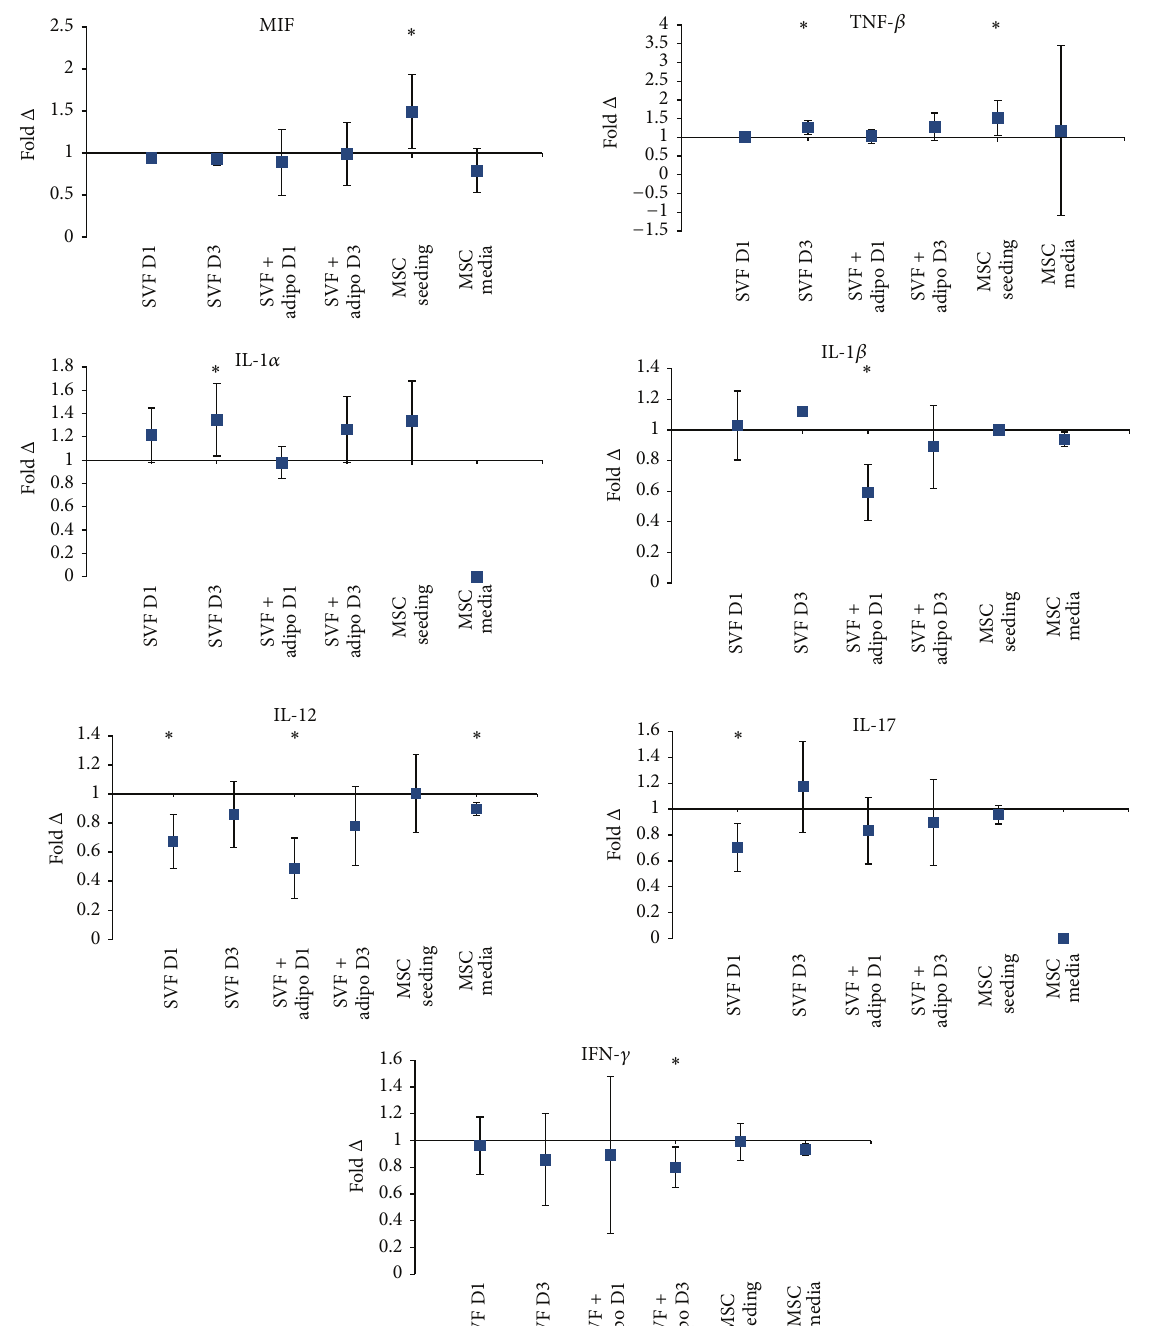
Figure 4: Fold change in concentration of proinflammatory cytokines detected across experiments Average fold change in concentration ( 𝑛 = 3 ) ± upper and lower confidence intervals at 95% ( 𝑦 -axis). Conditions ( 𝑥 -axis): stromal vascular fraction on day 1 (SVF D1), stromal vascularfractiononday3(SVFD3),stromalvascularfractionplusmatureadipocytesonday1(SVF+adipoD1),stromalvascularfractionplus mature adipocytes on day 3 (SVF + adipo D3), seeding experiment with purified MSCs (MSC seeding), and media change experiment with purified MSCs (MSC media). Conditions were all cultured in either standard culture media or HA media. Cytokines with a fold change less than one indicate a decrease in concentration with HA media treatment; a fold change greater than one indicates an increase in the cytokine with HA treatment. Macrophage migration inhibitory factor (MIF), tumor necrosis factor-beta (TNF- 𝛽 ; lymphotoxin-alpha), interleukin- 1 𝛼 (IL-1 𝛼 ), interleukin-1 𝛽 (IL-1 𝛽 ), interleukin-12 (IL-12), interleukin-17 (IL-17), and interferon-gamma (IFN- 𝛾 ). IL-1 𝛼 was not detected in the MSC media condition. IL-17 was only detected in one biological replicate in the MSC media condition. IL-1 𝛽 was only detected in one biological replicate in the SVF condition on day